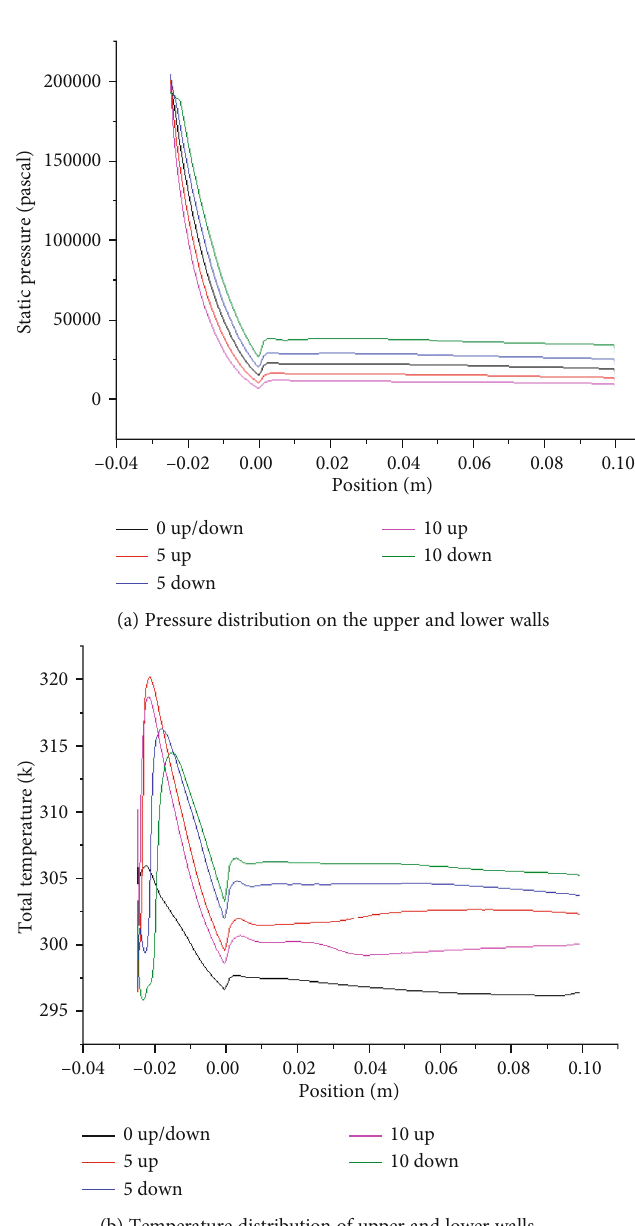
Figure 12: The pressure and temperature distribution of the upper and lower walls of Pr=0 at di ff erent angles of